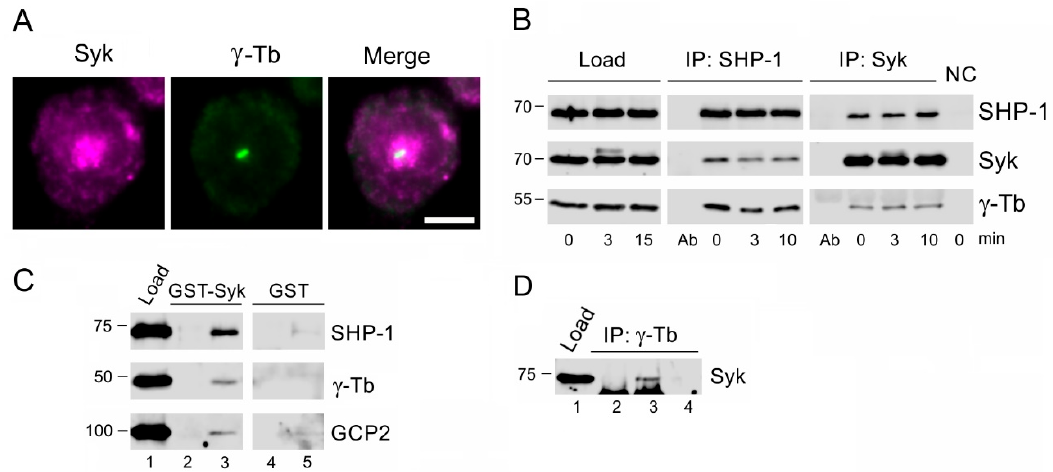
Figure 9. Syk kinase localizes to a centrosomal region and associates both with γ -tubulin complex proteins and SHP-1. ( A ) The double-label immunofluorescence staining of Syk and γ -tubulin: The cells were fixed with F / Tx / M and stained for Syk ( a ) in magenta and for γ -tubulin ( b ) in green. A superimposition of the images (Figure 9a,b) is also shown ( c ). Scale bar, 5 µ m. ( B ) The immunoprecipitation experiments: Extracts from the nonactivated (0 min) or antigen-activated (3 min, 10 min) BMMCs were precipitated with the immobilized Abs specific to SHP-1 or Syk. The blots were probed with Abs to SHP-1, Syk, and γ -tubulin ( γ -Tb). Ab, immobilized Ab not incubated with cell extract; NC, carrier without Ab, incubated with cell extract (negative control). ( C ) The pull-down assay: Extracts from BMMCs incubated with the GST-tagged whole-length Syk or GST alone were immobilized on glutathione-Sepharose beads. The blots of the bound proteins were probed with abs to SHP-1, γ -Tb, and GCP2. The load ( lane 1 ), the immobilized GST-Syk not incubated with cell extracts ( lane 2 ), the proteins bound to GST-Syk ( lane 3 ), the immobilized GST alone not incubated with cell extracts ( lane 4 ), and the proteins bound to GST alone ( lane 5 ). ( D ) The immunoprecipitation experiment: Extracts from BMMCs were precipitated with immobilized Ab specific to γ -tubulin. The blot was probed with Ab to Syk. The load ( lane 1 ), the immobilized Ab not incubated with cell extracts ( lane 2 ), the precipitated proteins ( lane 3 ), and the carrier without Ab and incubated with cell extracts ( lane 4 ).